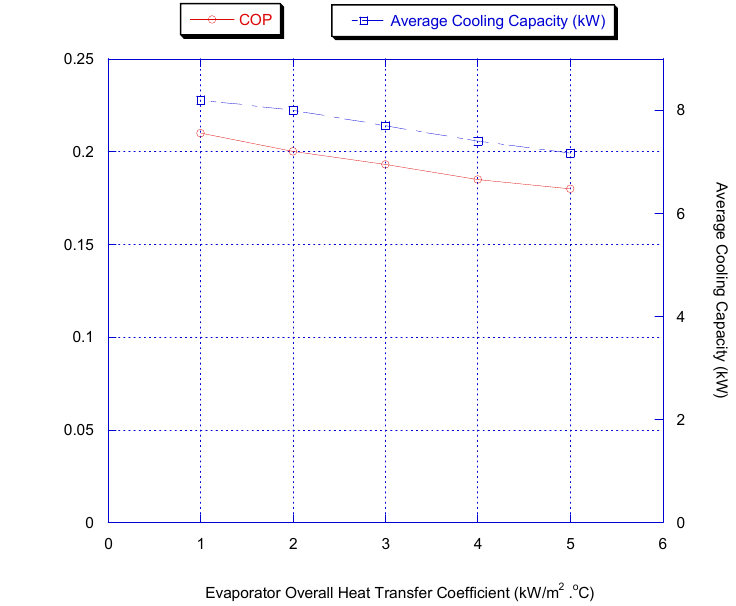
Figure 3. Effect of evaporator’s overall heat transfer coefficient on chiller average cooling capacity and COP (results are at chiller nominal operating conditions, shown in Appendix B).